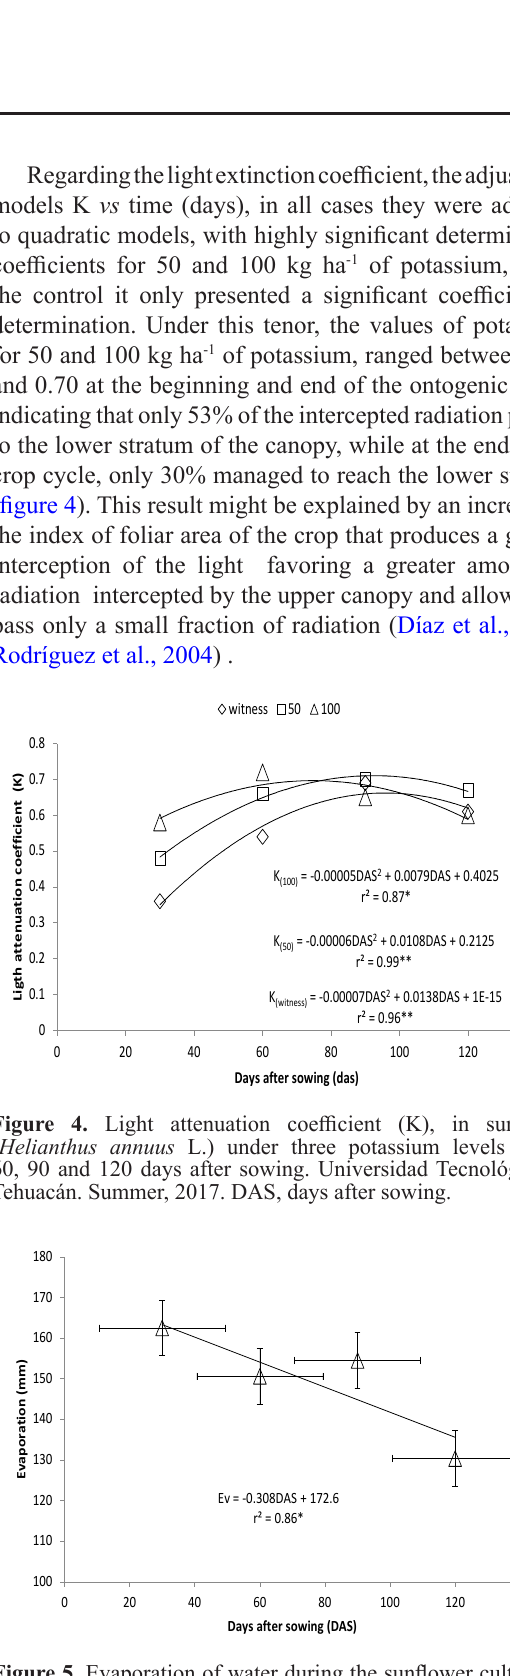
Figure 5. Evaporation of water during the sunflower cultivation cycle ( Helianthus annuus L.), at 30, 60, 90 and 120 das. Universidad Tecnológica de Tehuacán. Summer,